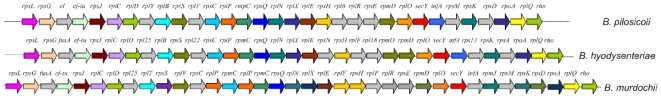
Conservation of the gene cluster for ribosomal proteins in B. pilosicoli 95/1000, B. hyodysenteriae WA1 and B. murdochii 56-150T.